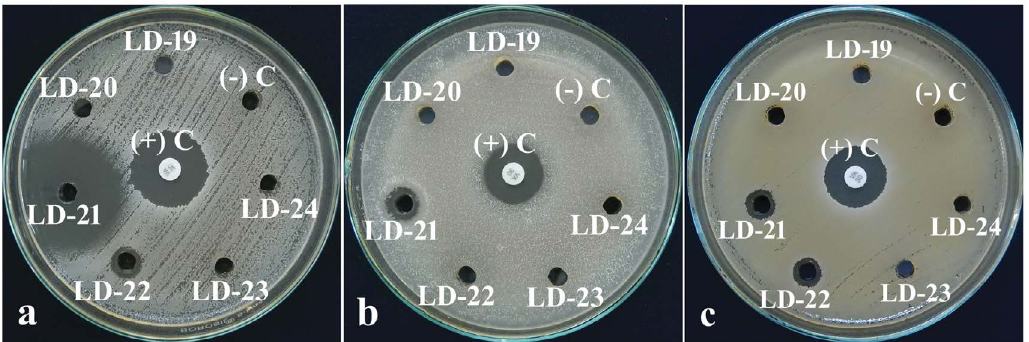
Fig. 3. Antibacterial activity of culture filtrate of bioactive isolate Streptomyces LD-21 and other isolates on a lawn of (a) Staphylococcus aureus, (b) Bacillus subtilis and (c) Micrococcus luteus. (+) C: Positive Control (Vancomycin disc 30µg); (-) C: Negative Control (uninoculated